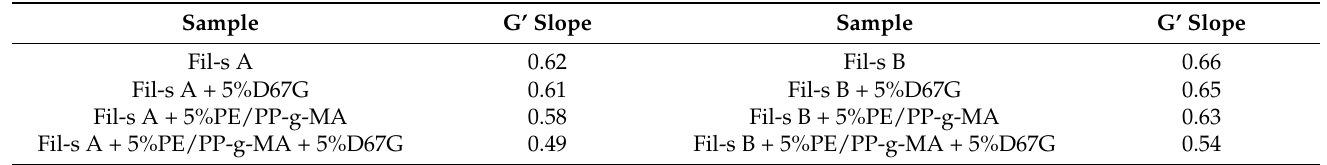
Table 4. G’ slopes at low frequencies for both Fil-s A and Fil-s B